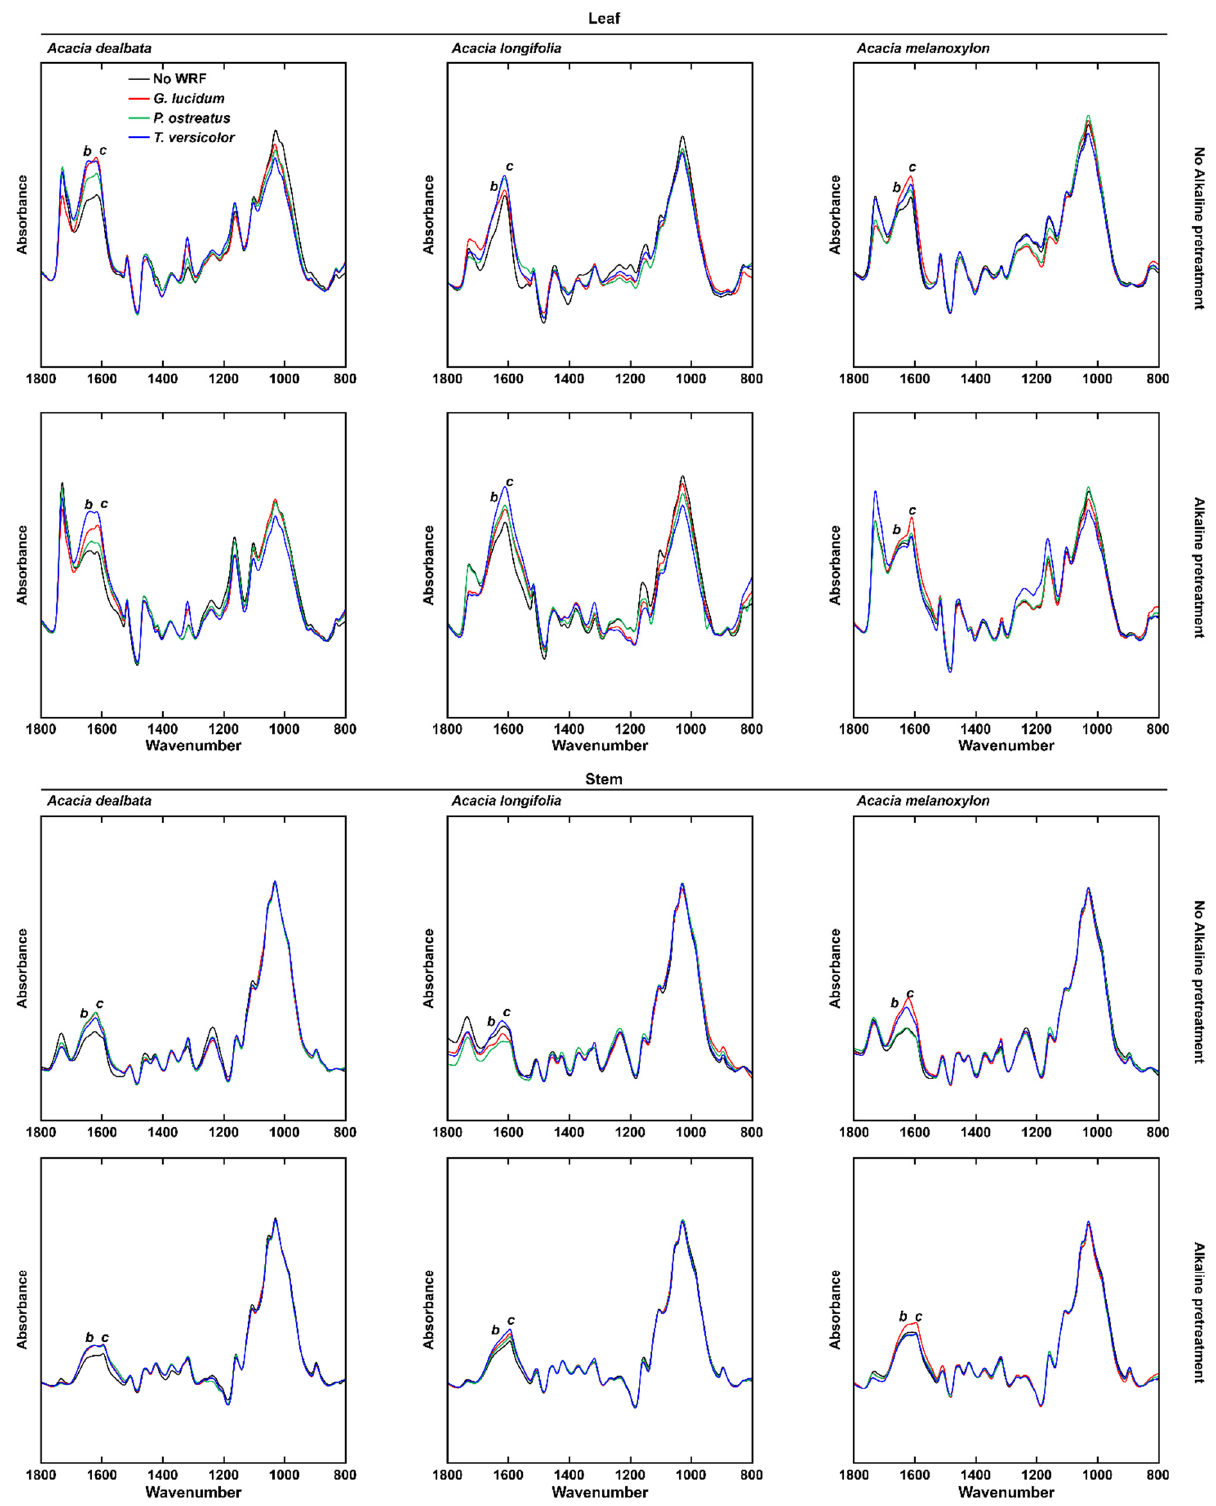
Figure 3. Mean FTIR-ATR spectra of milled but not organic solvent-washed biomass samples from Figure 3. Mean FTIR ‐ ATR spectra of milled but not organic solvent ‐ washed biomass samples from Acacia spp., treated with three white-rot fungi species (WRF; 30 days) and/or in combination with an Acacia spp., treated with three white ‐ rot fungi species (WRF; 30 days) and/or in combination with alkali pretreatment. Spectral bands: b , 1640 cm − 1 ; c , 1612 cm − 1 an alkali pretreatment. Spectral bands: b , 1640 cm − 1 ; c , 1612 cm − 1 .